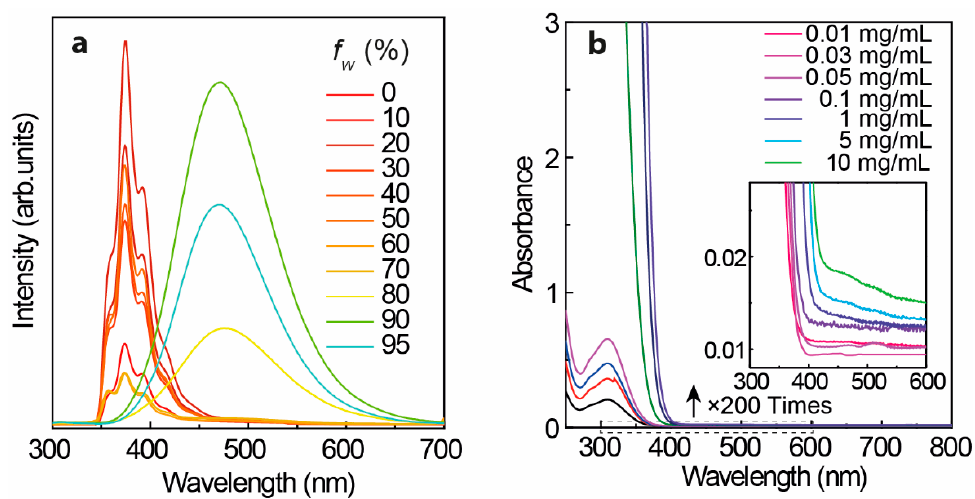
Figure 2. ( a ) Emission spectra of TPE in THF/H 2 O binary solvents under 280 nm excitation with varied addition of water volume fraction ( f w (%)) into TPE solution (in THF, 0.1 mg/mL), and ( b ) UV–Vis spectra of TPE in THF solvent (all measurement operated in the quartz cuvettes through 1 mm excitation light path length).